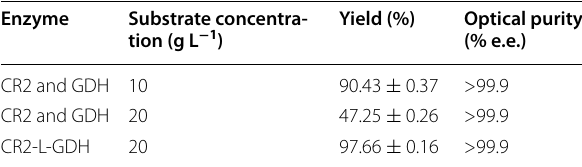
Table 4 Comparison of ( S )-DHTP production efficiency between free CR2 and GDH and fusion enzyme